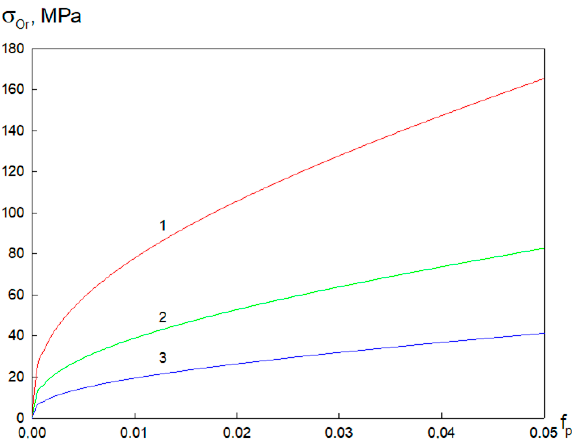
Figure 5. Dependence of Orowan stresses σ Or in alloy A356 strengthened by ScF 3 particles on the volume fraction of hardening particles, calculated for ∆ T = 100 K. Particle size: 1— δ p = 20 nm; 2— δ p = 40 nm; 3— δ p = 80